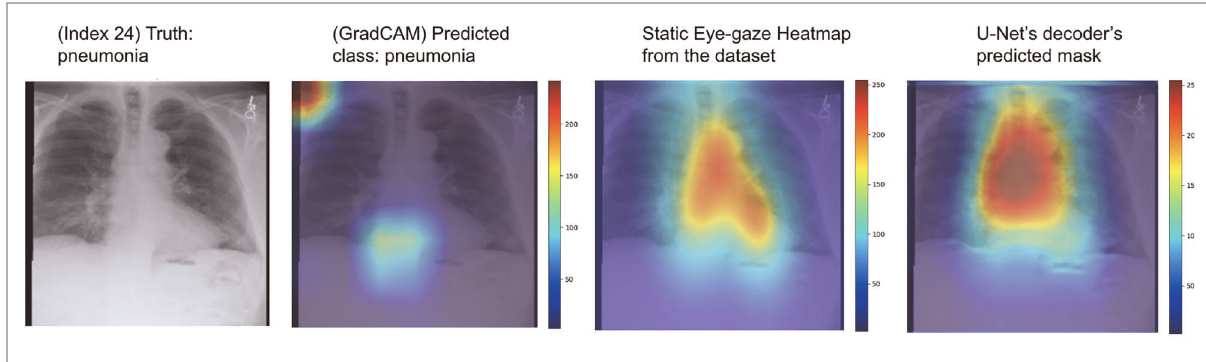
FIGURE 4 Heatmaps generated from Grad-CAM and the (12) ’ s U-Net ’ s decoder for a pneumonia class example correctly classi fi ed.